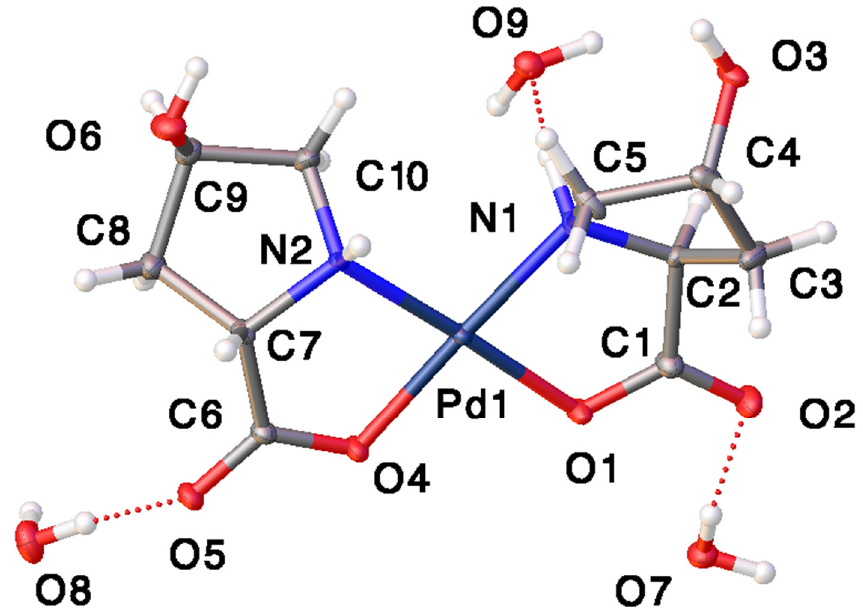
Figure 7. Thermal ellipsoid plot of the molecular structure of crystalline cis -bis-( trans -4- hydroxyprolinato)palladium(II) trihydrate, ( 3 ). Thermal ellipsoids are shown at the 50% probability level. CCDC:1913624.